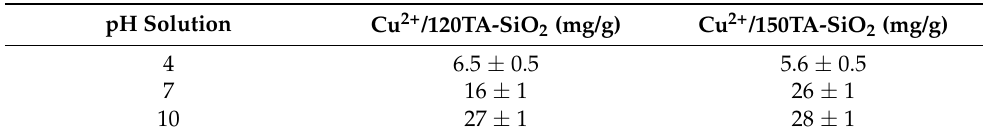
Table 6. Adsorption amount of copper as Cu 2+ /TA-SiO 2 (mg/g), detected by ICP-MS at different pH